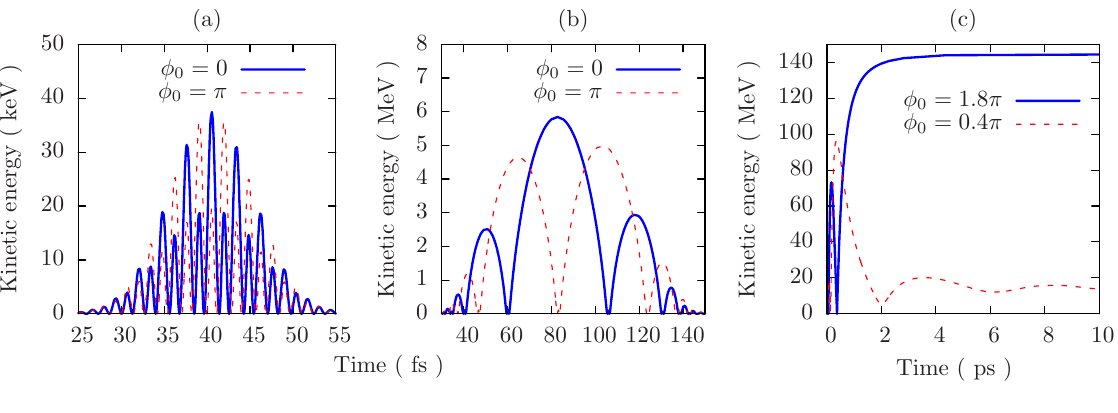
Figure 3. Single-electron model of longitudinal acceleration in a 12-fs (FWHM) RPLP ( k z 500 with λ = 800 nm). The electron is initially at rest at z = 0 . ( a ) At low 0 0 0 ∼ intensity ( a 2 = 0 . 1 ), the electron experiences a quasi-harmonic motion, with slightly longer z excursions in accelerating half field-cycles; ( b ) At the longitudinal acceleration threshold ( a 2 = 1 ), this phenomenon is stronger but the final kinetic energy remains relatively small z (in the keV range); ( c ) Above threshold ( a 2 = 10 ), the electron escapes the laser pulse with z a relativistic longitudinal momentum. During the sub-cycle acceleration represented in ( c ), the electron stays locked to the phase of the pulse carrier.